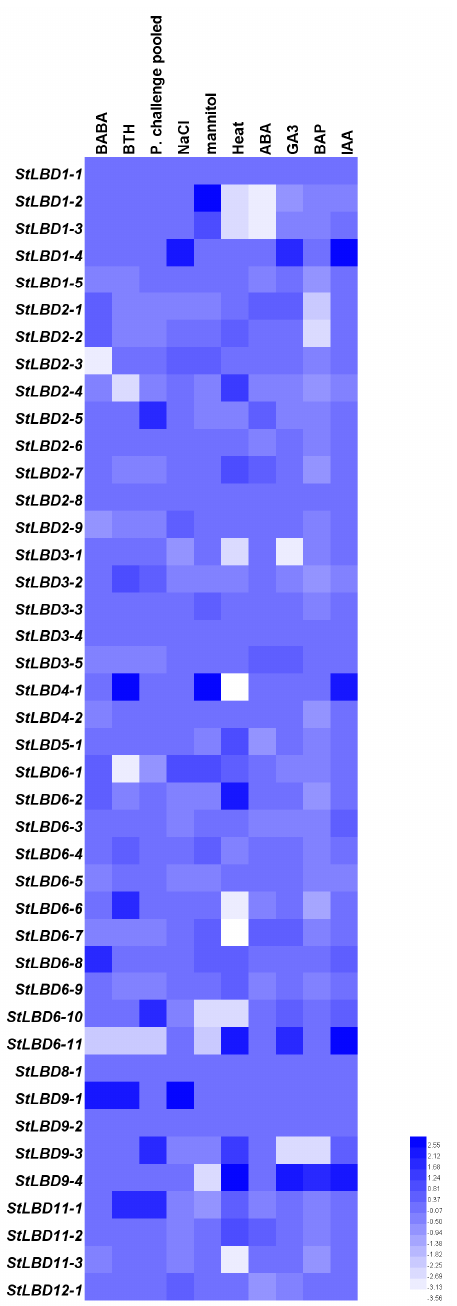
Figure 6. Heatmap of the expression profile of potato LBD genes under ten different biotic or abiotic stresses. Transcripts were detected with RNA-Seq technology. Abiotic stresses include sodium chloride, mannitol, and heat. Biological stresses include Phytophthora infestans , and stress-elicitors acibenzolar-S-methyl (BTH) and DL-b-amino-n-butyric acid (BABA). Other stress responses were mainly induced by four plant hormones: abscisic acid (ABA), 6-benzylaminopurine (BAP), gibberellic acid (GA3), and indole-3-acetic acid (IAA). Blue and white in the figure were used to indicate the gene expression level in plant tissues under specific conditions. Blue indicates gene up-regulation, while white indicates gene down-regulation.